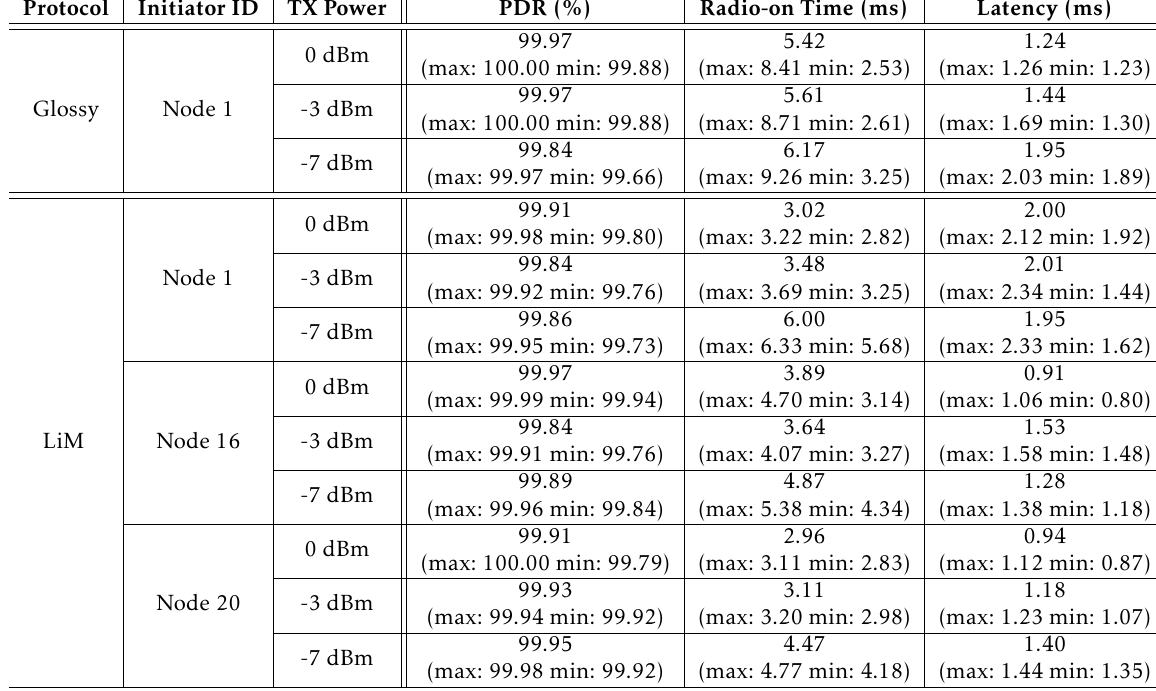
Table 2. Summary of experimental results. In all experimental scenarios, LiM maintains a best-effort end-to-end PDR and latency, taking advantage of concurrent transmissions. Besides, LiM decreases approximately 5 ms radio-on time compared to the default configuration of Glossy. The maximum value of radio-on time in Glossy is N = 5, while the minimum value is N = 1. LiM reduces the radio-on time by at least 3 ms compared to the default setting of Glossy (i.e., N =